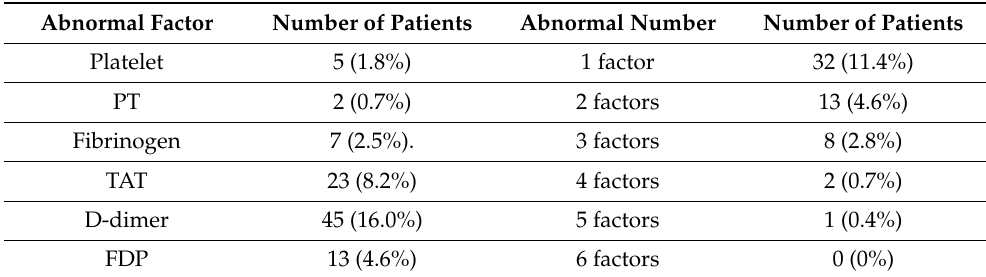
Table 5. Occurrence rate of abnormal coagulation factors in 281 patients with hepatic hemangiomas. Abnormal Factor